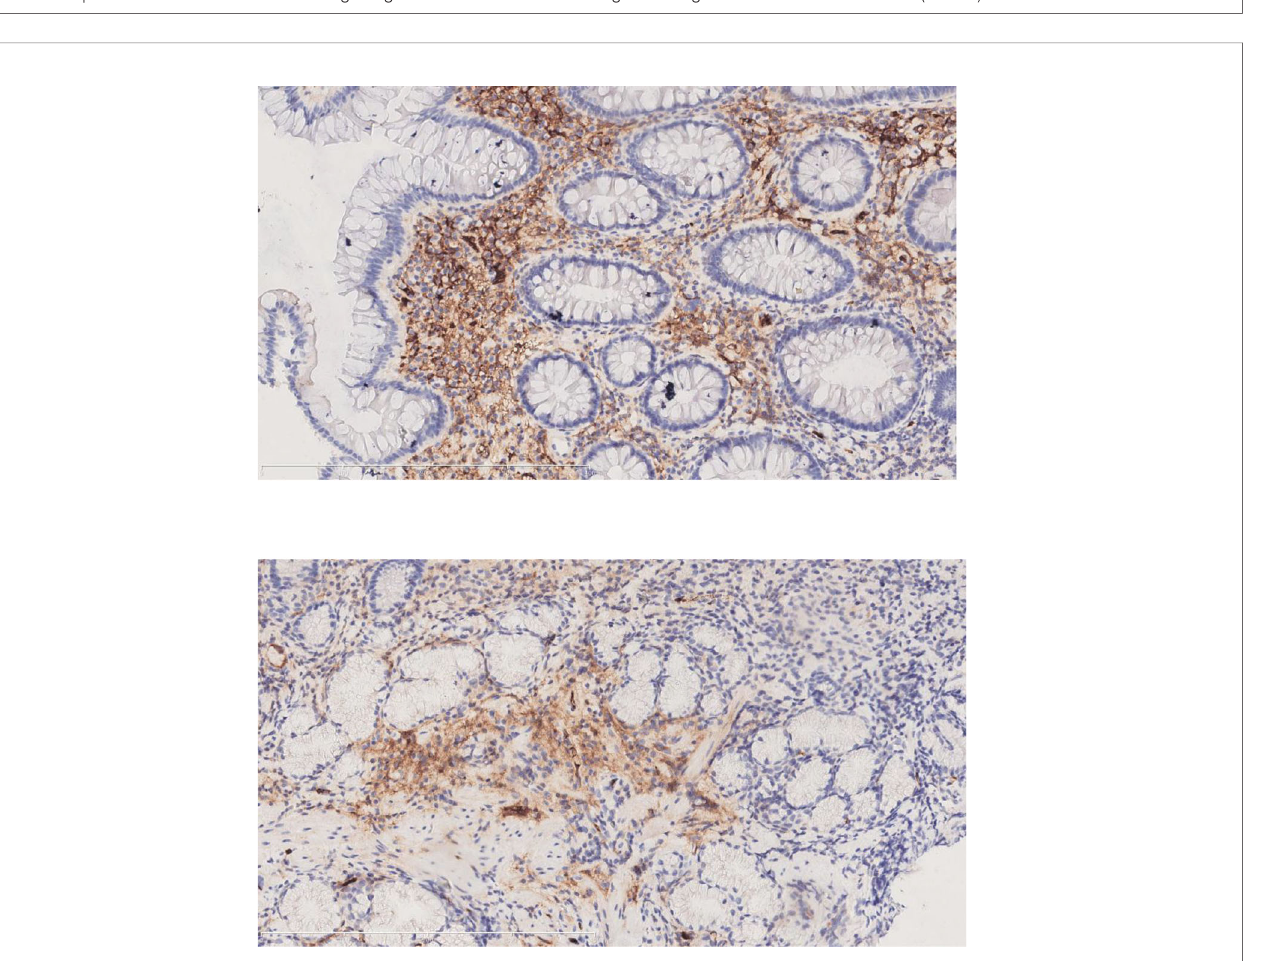
FIGURE 2 | The immunohistochemical staining for IgG4 of the left submandibular gland and gastric antrum mucosal tissue